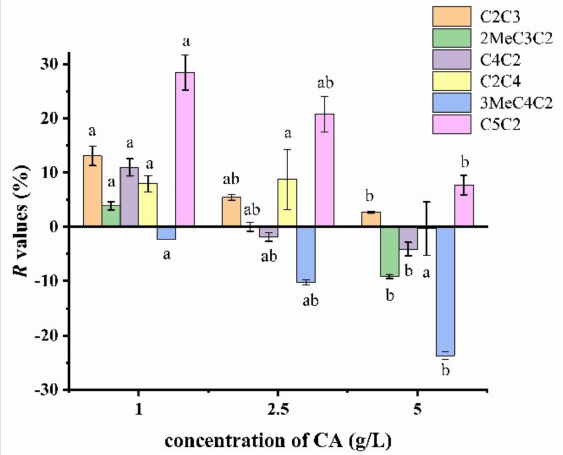
Figure 4. R values of esters in 1, 2.5 and 5 g/L of CA solution. Different letters indicate significant difference for each ester ( p < 0.05).